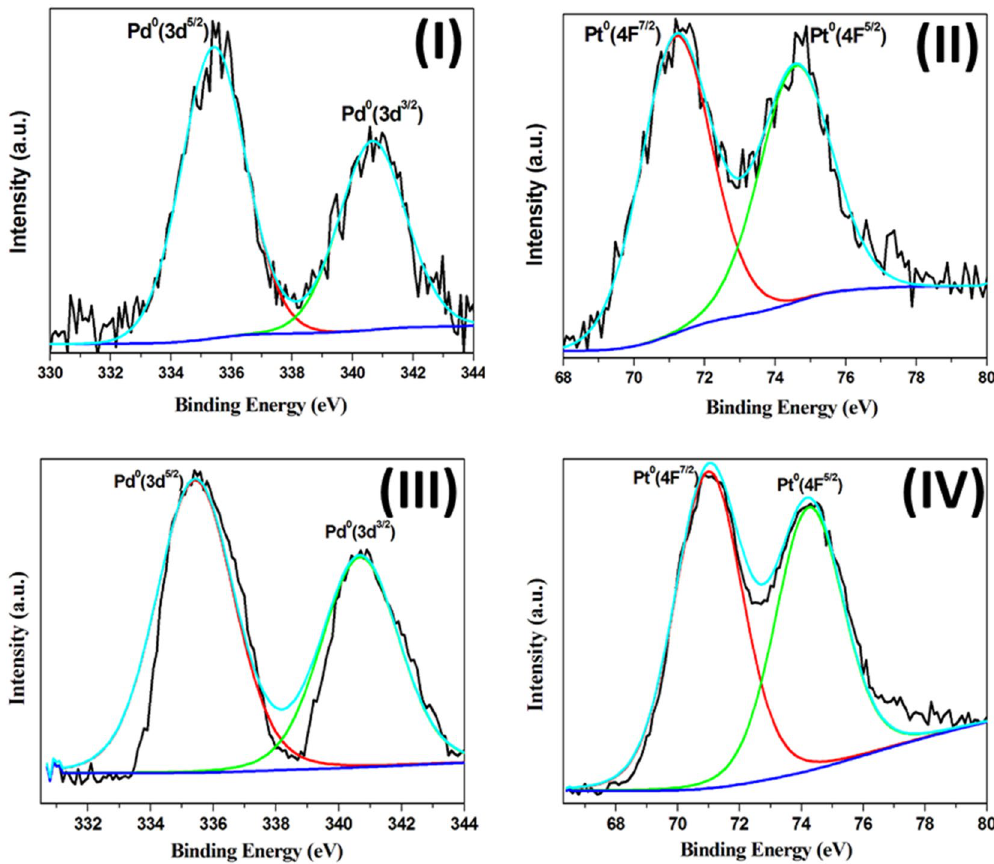
Figure 3. High resolution-XPS spectra of ( I ) Pd 3d 5/2 and 3d 3/2 electrons in Pd n (SG) m clusters, ( II ) Pt 4F 5/2 and 4F 7/2 electrons in Pt n (SG) m clusters, ( III ) Pd atoms in the single alloy nanoclusters ((Pd 0.5 –Pt 0.5 ) n (SG) m ), and ( IV ) Pt atoms in the single alloy nanoclusters ((Pd 0.5 –Pt 0.5 ) n (SG) m